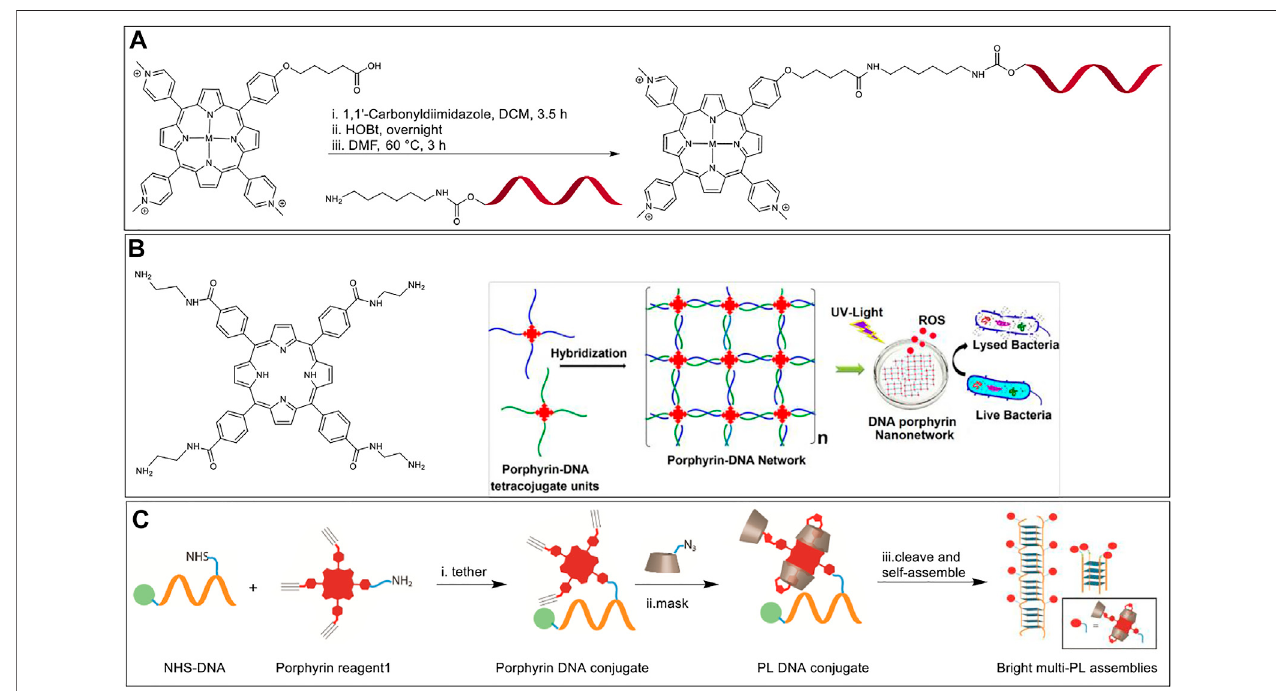
FIGURE 4 | (A) Synthesis of hybrid-metalloporphyrin-DNA conjugates from the reaction of 5 ′ -amino-modi fi ed DNA and a benzotriazole activated porphyrin. M (cid:1) Mn (III)-axialligand, Ni (II),Cu (II),Co(II).DNA sequence (cid:1) T17(Casas et al.,1993). (B) Left: Atetra aminefunctionalized porphyrin macrocycle;Right:Apair ofporphyrin- DNA hybrids tetrasubstituted with complementary DNA arms that self-assemble to form an ordered network. When excited with UV light the nanonetwork produces ROSandexhibitsantibacterialactivity.Adapted withpermissionfrom(Kumarietal.,2017). (C) Abottom-upapproachtodevelop G-quadruplex-based fl uorescent nanostructures thatinvolves (i) synthesis of aporphyrin-DNA hybrid via NHS ester-aminecoupling, (ii) masking the porphyrin with PM β CD hosts via CuAAC, and (iii) self- assembly of the fi nal conjugate.